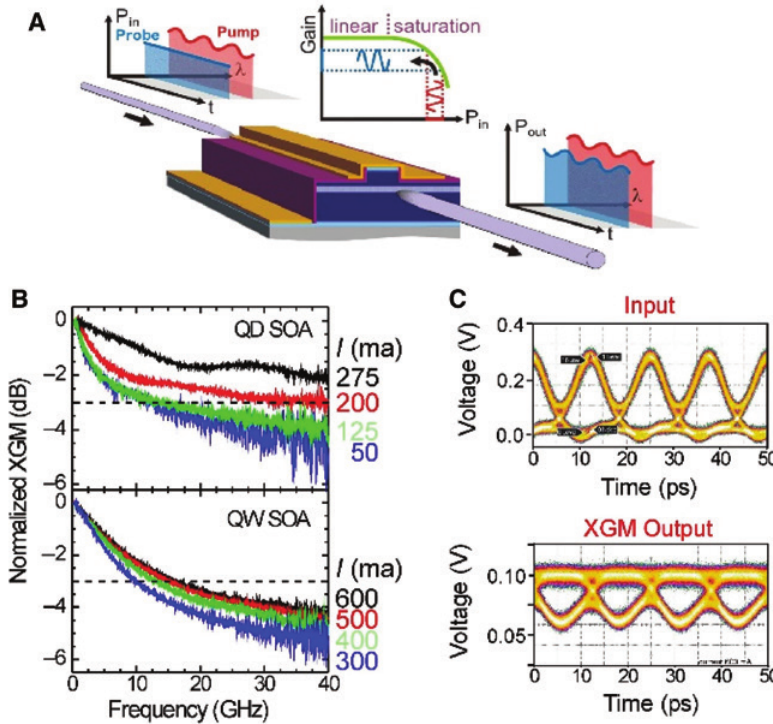
Figure 12: Cross-gain modulation of a semiconductor optical amplifier